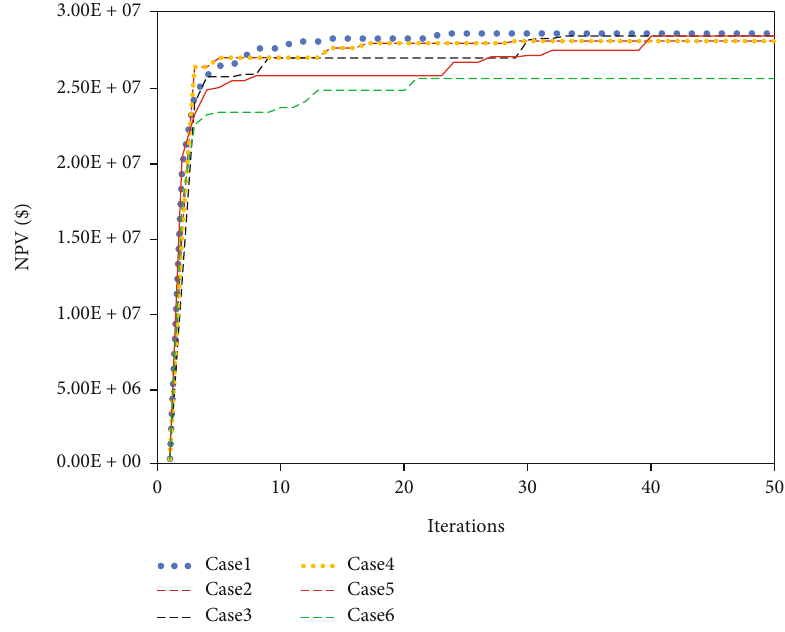
Figure 9: The NPV with respect to number of iteration based on six cases.